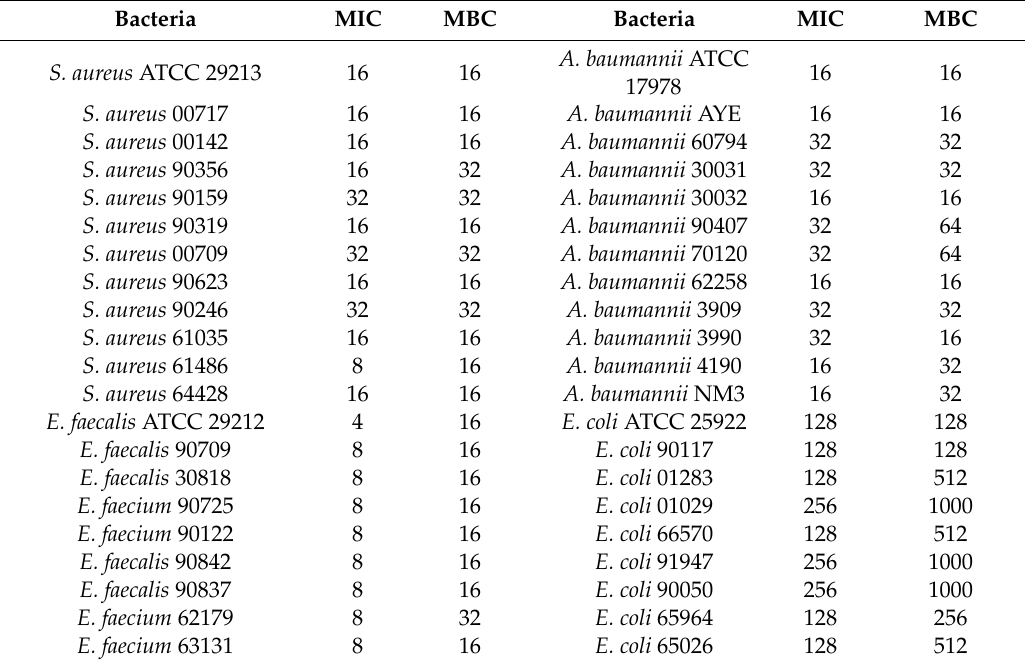
Table 3. MIC ( µ g / mL) and MBC ( µ g / mL) values of PYED-1 on a panel of Gram-negative and Gram-positive multidrug